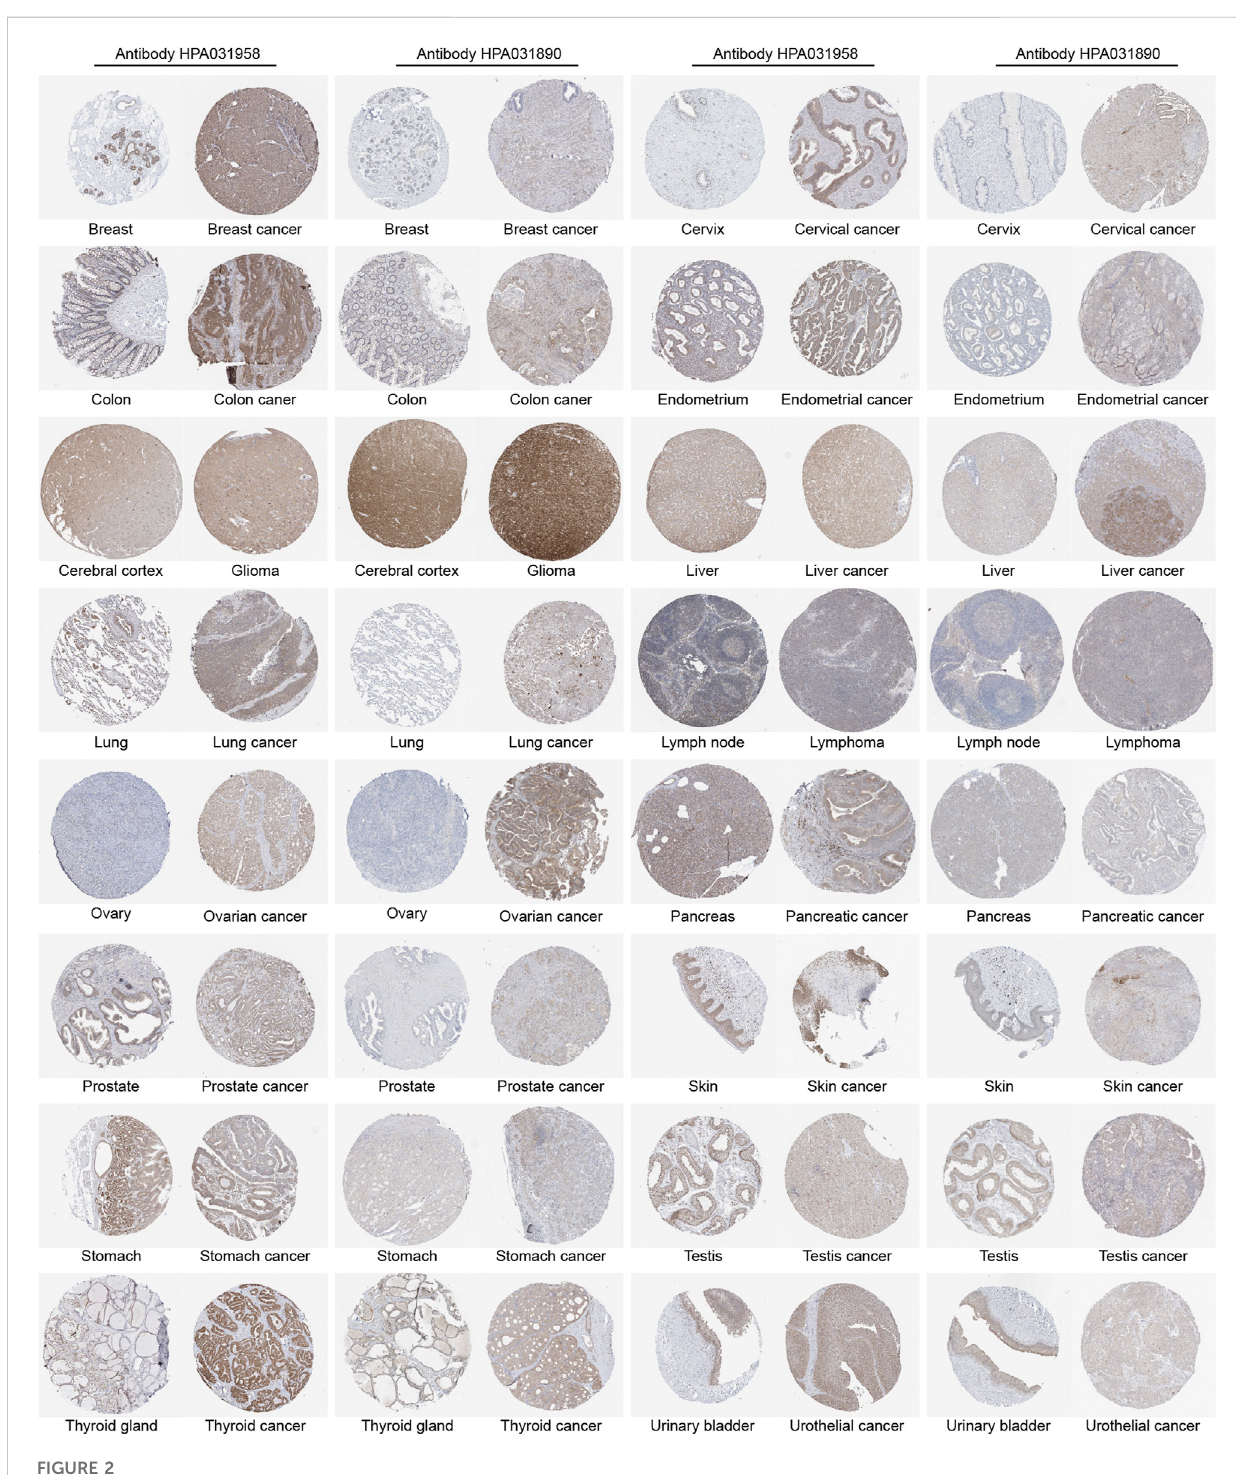
FIGURE 2 Representative immunohistochemical images of NALCN protein expression level in normal and tumor tissues (antibodies for immunohistochemistry: HPA031958,